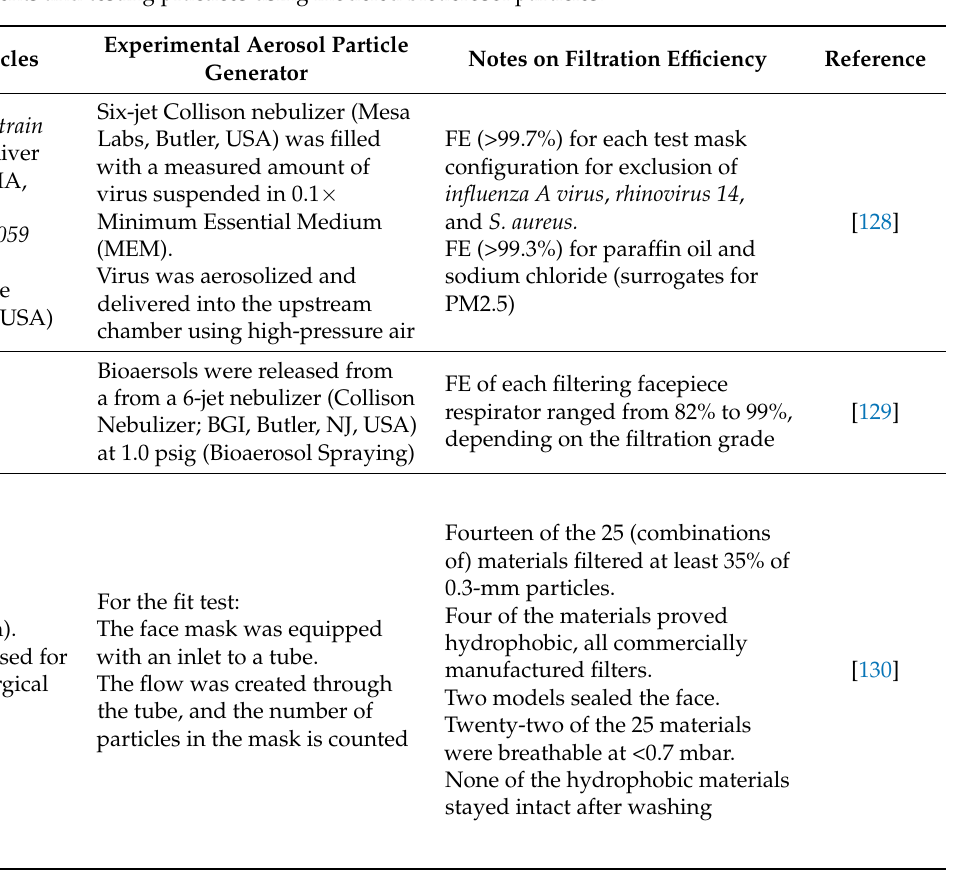
Table 7. Summary of face mask and respirator filtration experiments and testing practices using modeled bioaerosol